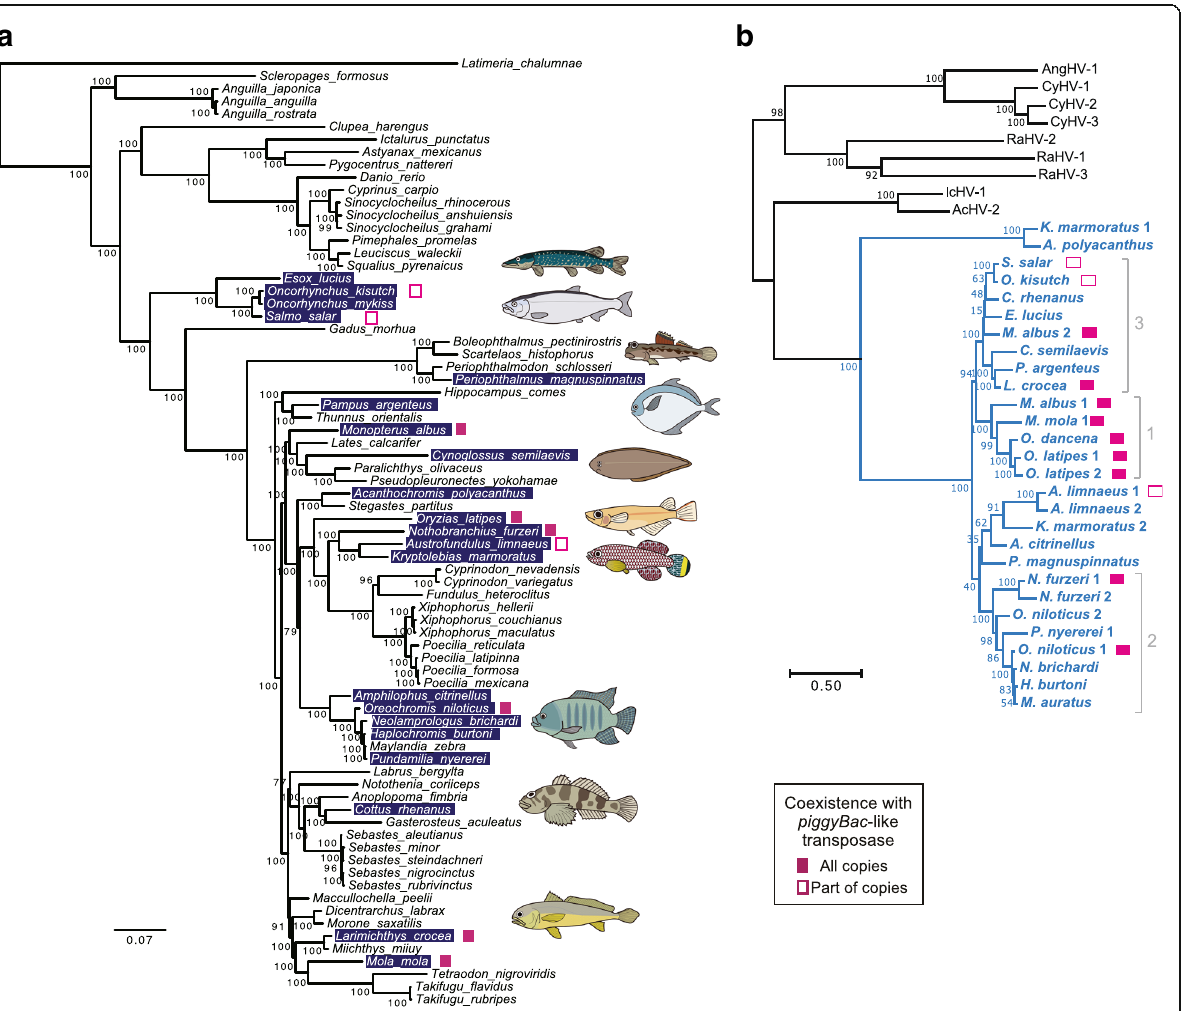
Fig. 1 Teratorn -like viruses are widely distributed in teleost fish genomes ( a ) Result of a tblastn search for 13 herpesvirus core genes of medaka Teratorn against publicly available genome data of teleost fish species. Species that appear to contain Teratorn -like virus (> 8 of the 13 herpesvirus core genes; E-value < 10 − 3 ) are highlighted in blue. The phylogenetic tree was constructed by Bayesian inference, based on the concatenated nu- cleotide sequence of 17 host genes (Betancur-R. R. et al., 2013 [39]). Species in which Teratorn -like viruses are adjacent to a piggyBac -like transpo- sase gene are marked by magenta squares (solid, fusion for all copies; outlined, co-localization for only some of the copies). b Maximum- likelihood tree based on the concatenated amino acid sequences of five herpesvirus genes (major capsid protein, capsid triplex protein, DNA heli- case, DNA polymerase and DNA packaging terminase) from Teratorn -like viruses in teleosts and exogenous alloherpesvirus species. Teratorn -like vi- ruses are depicted in blue. Elements that harbor a piggyBac -like transposase gene are marked by magenta squares. For the designated numbers on the right (1, 2, 3), see Fig. 4c and main text. The scale bars represent the number of substitutions per